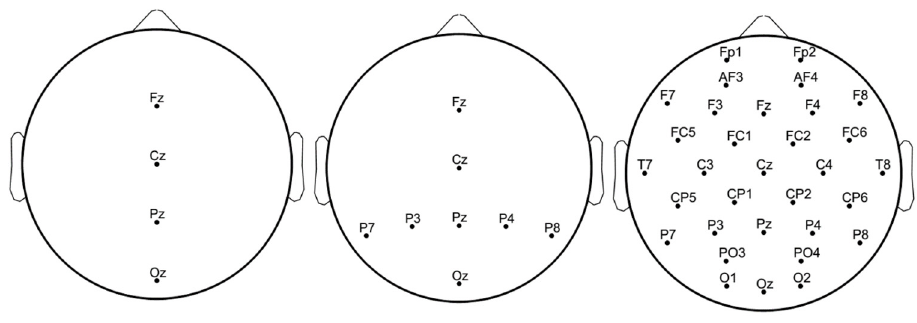
Figure 9. The electrodes configurations with 4, 8 and 23 channels. Figure 10 shows the classification results for different channel configurations